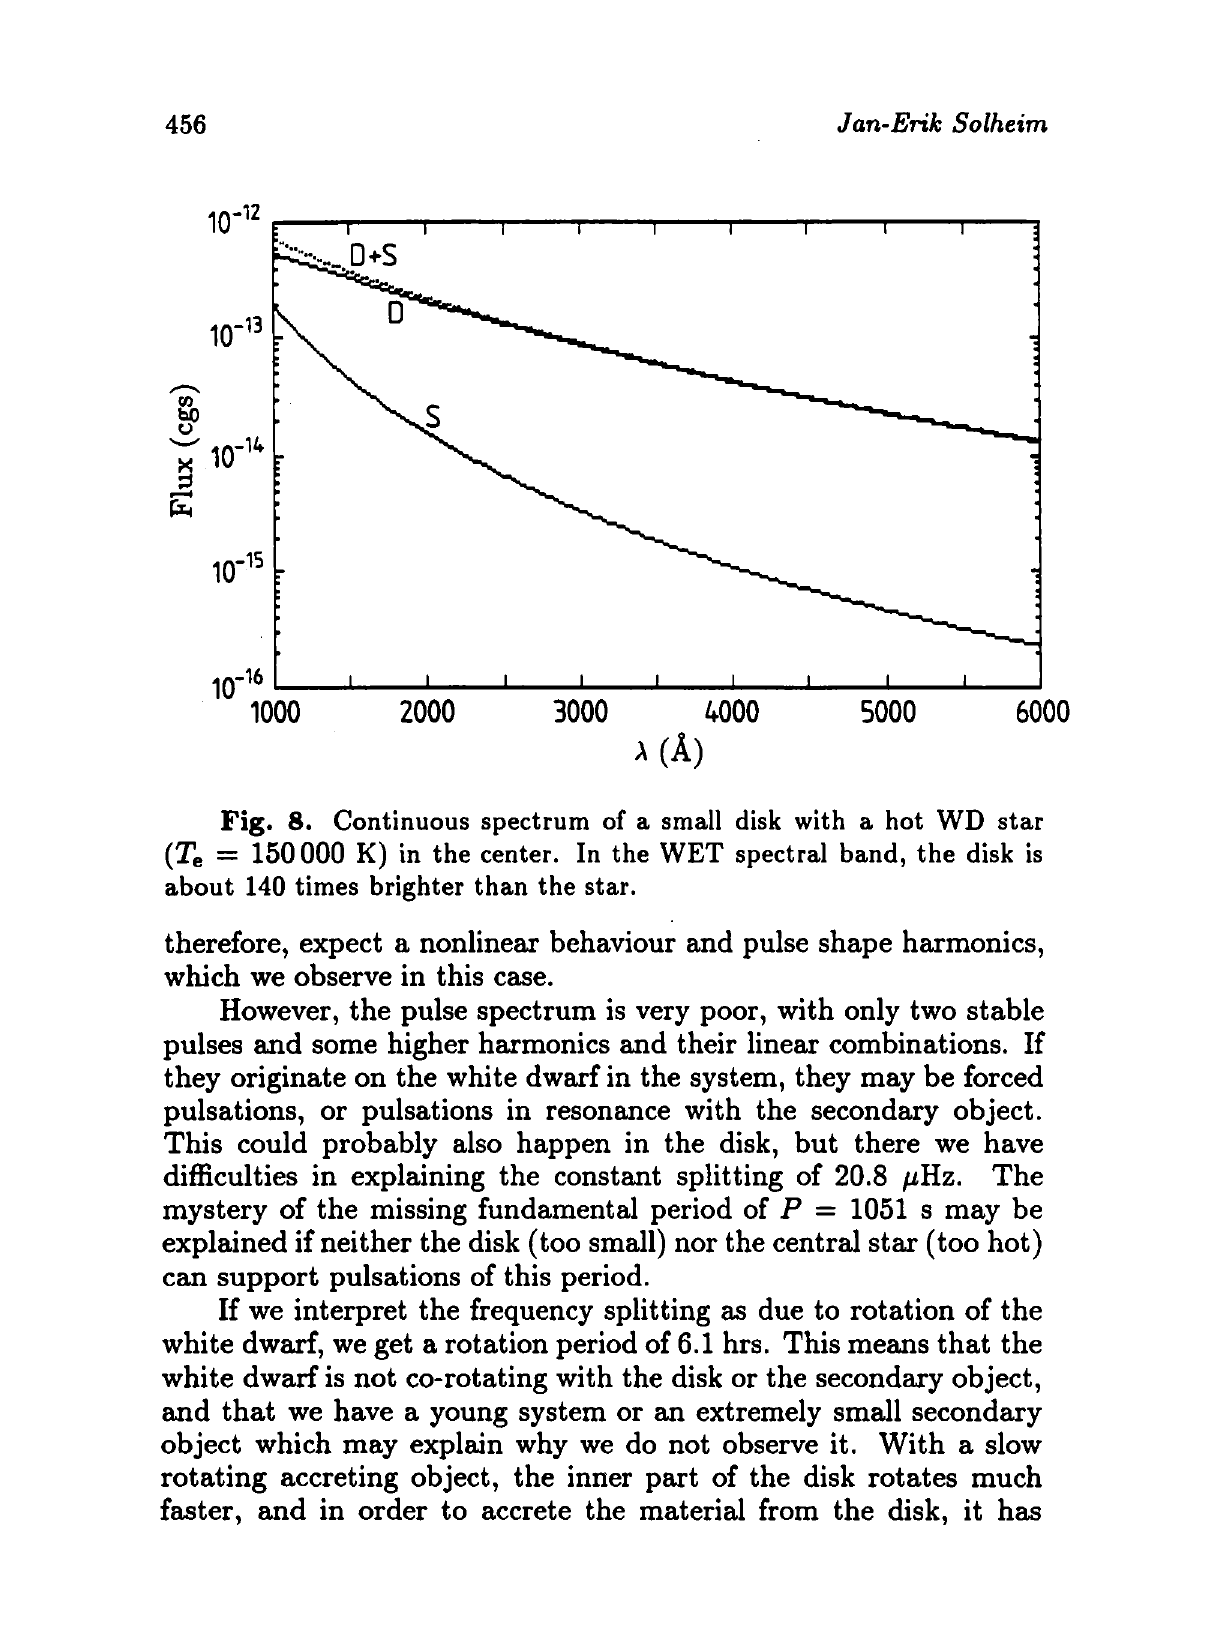
Fig. 8. Continuous spectrum of a small disk with a hot WD star (T = 150000 K) in the center. In the WET spectral band, the disk is e about 140 times brighter than the